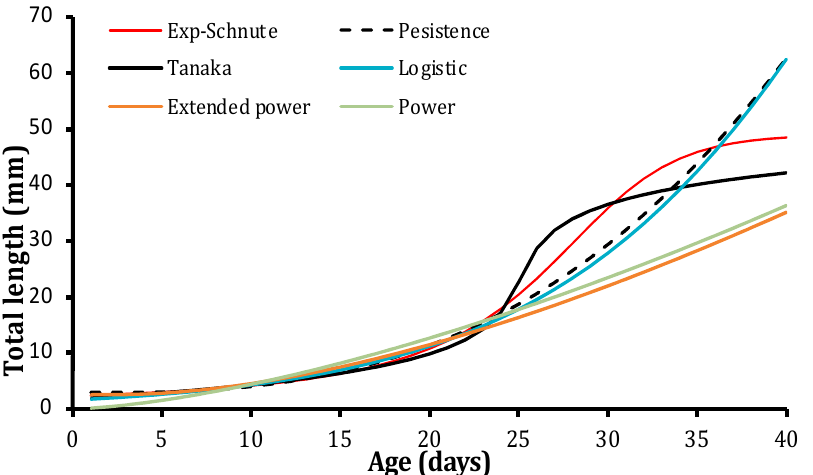
Figure 3. Trajectories of the most biologically meaningful models used to describe the growth of the Totoaba macdonaldi under laboratory conditions.